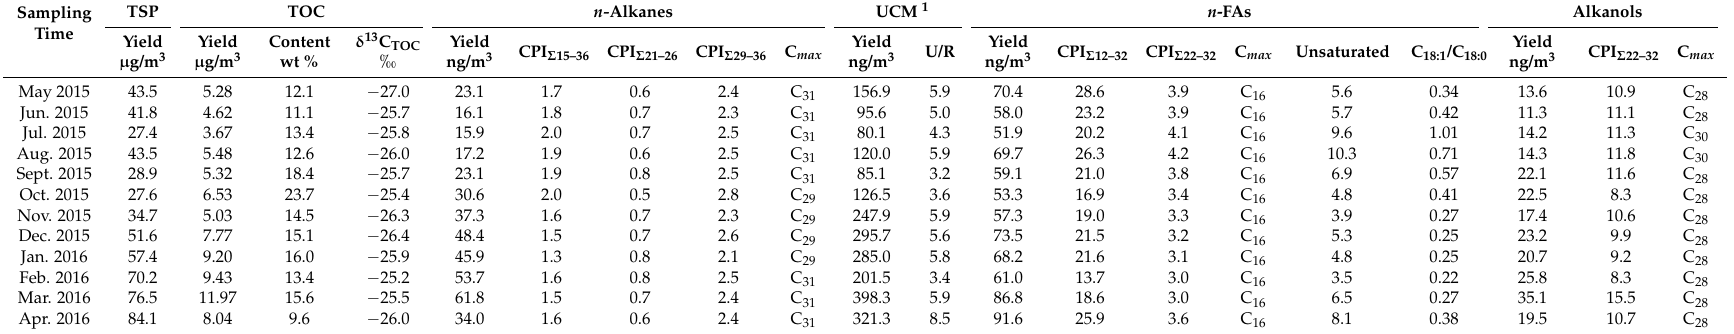
Table 1. Summary of yields and important proxies of the hydrocarbon, n -FA and alkanol fractions in ambient aerosols, collected in Xiamen, China. Sampling